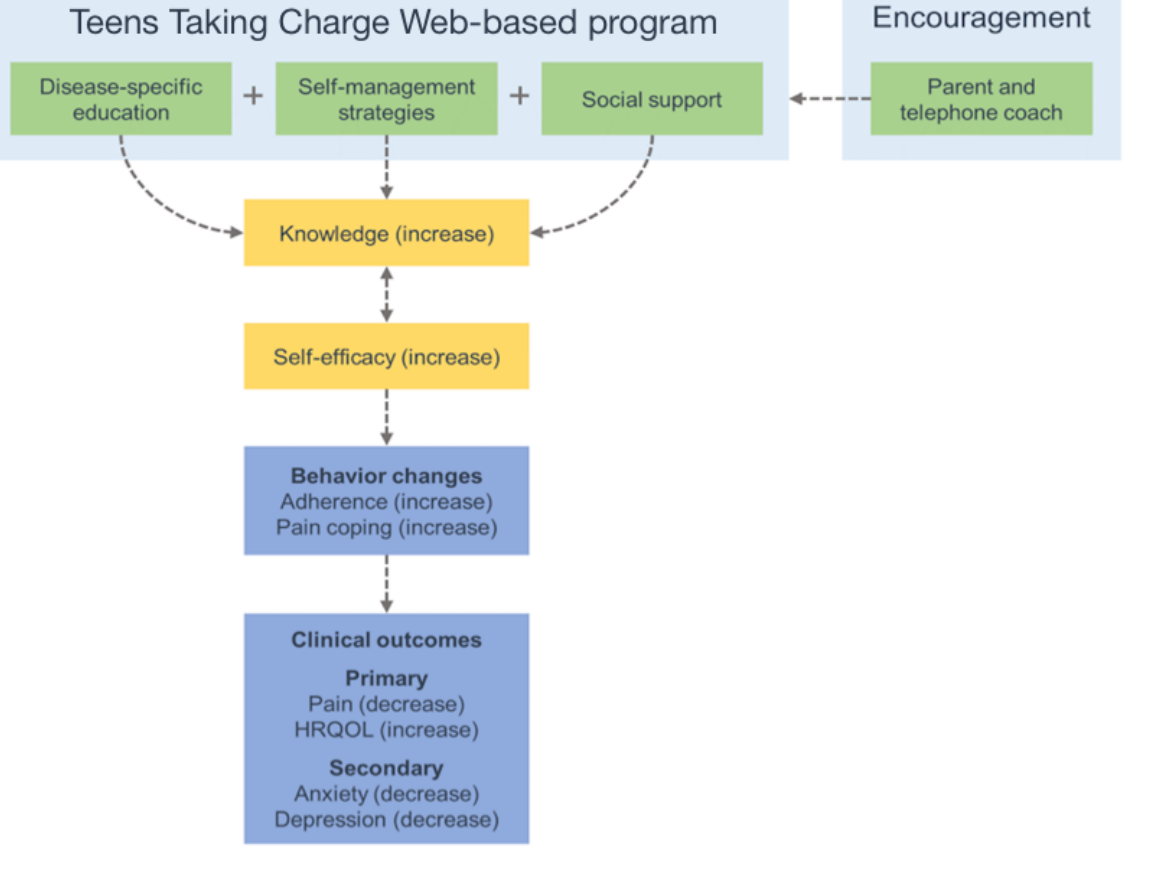
Figure 1. Conceptual model outlining the hypothesized mechanism of action of the Teens Taking Charge: Managing JIA Online Web-based intervention. JIA: juvenile idiopathic arthritis. HRQL: health-related quality of